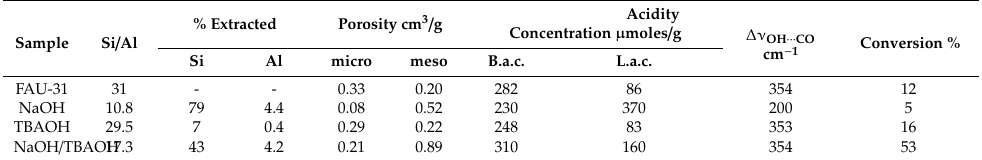
Table 1. The Si / Al values, the amounts of Si and Al extracted, N 2 porosity, concentration of Brønsted and Lewis acid sites, the acid strength of Si-OH-Al groups ( ∆ ν OH ··· CO ). Initial (after 1 min of reaction) conversion in α -pinene isomerization at 393 K. The data concerning parent zeolite Y (FAU-31) and zeolites desilicated by NaOH, TBAOH and NaOH / TBAOH mixture (10 mol % of TBAOH) at 293 K are presented. The data were adapted (with the permission) from